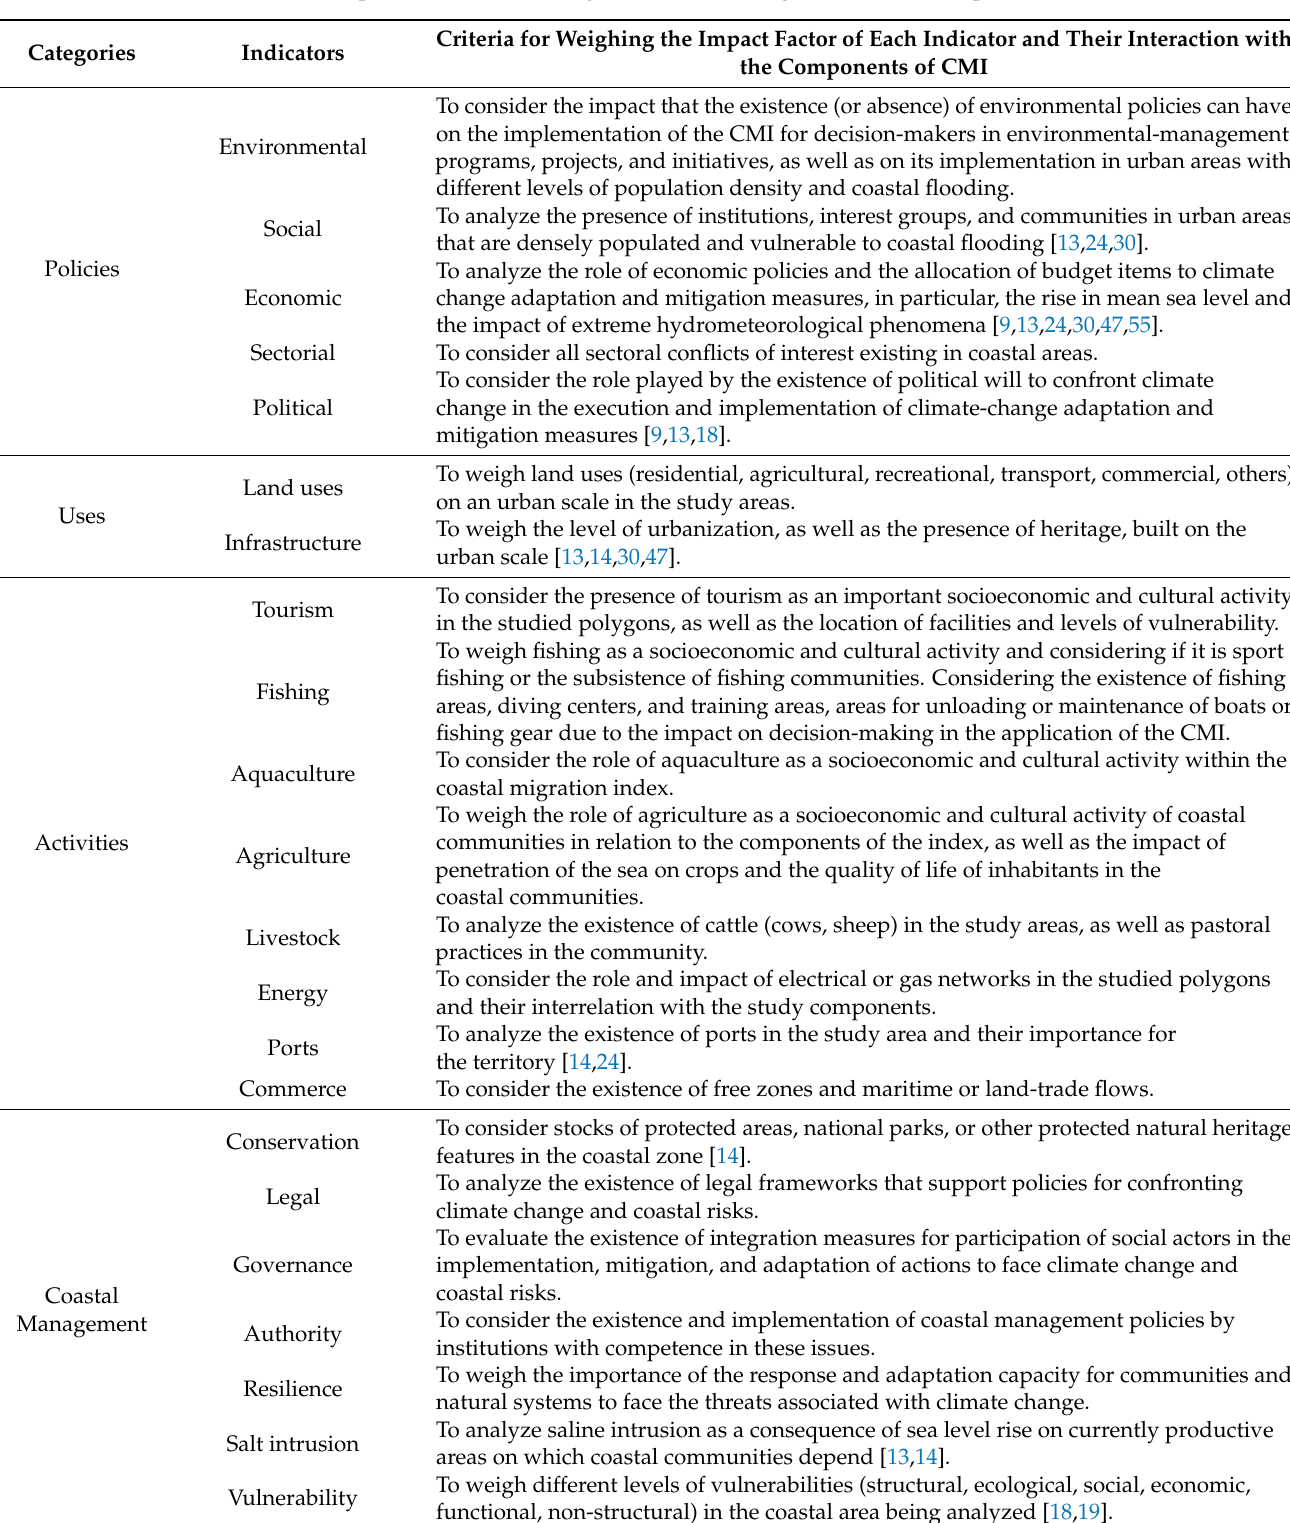
Table 1. Component ratio of the weights, n i , of each weight, C i , that make up the